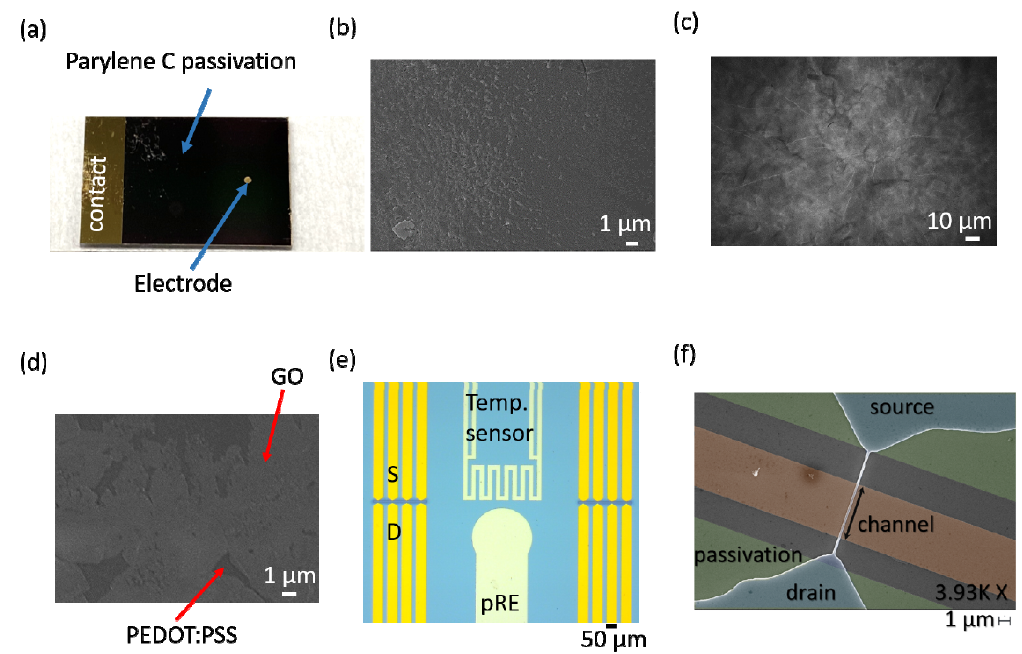
Figure 1. Photograph of the used electrode test structure ( a ). An image of a PEDOT:PSS electrode surface ( b ). SEM image of a PEDOT:PSS electrode coated with GO ( c ). High-resolution image of a GO-coated PEDOT:PSS electrode showing micro holes in the GO film ( d ) Microscopy image showing the SiNW arrays, an integrated temperature sensor, and an on-chip pRE ( e ). SEM image of a single SiNW-FET ( f ).